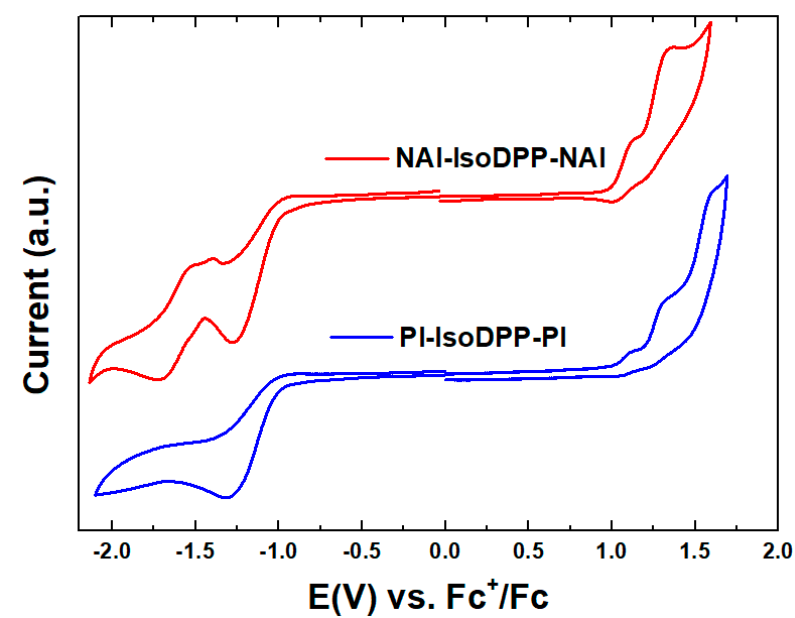
Figure 4. Cyclic voltammograms of NAI-IsoDPP-NAI and PI-IsoDPP-PI.